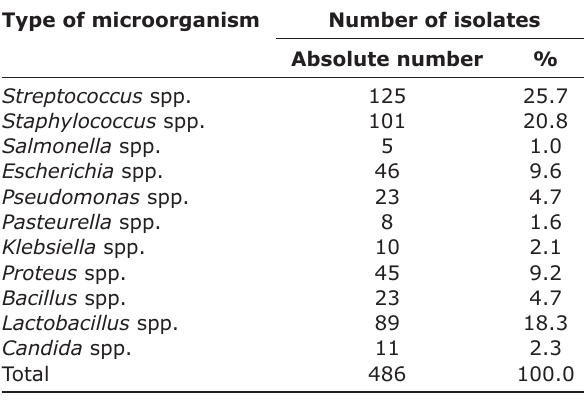
Table-1: Results of microbiological research of cow’s milk, patients with mastitis (n=103). Type of